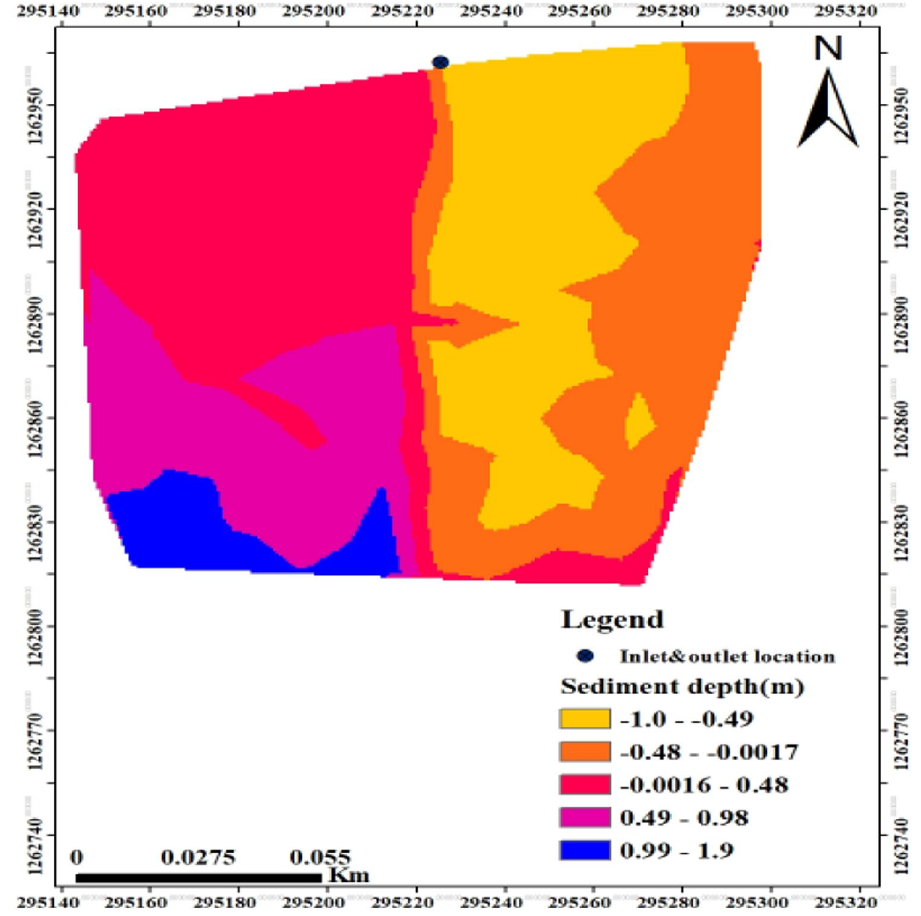
Fig. 12 Adebra NSR sediment thickness